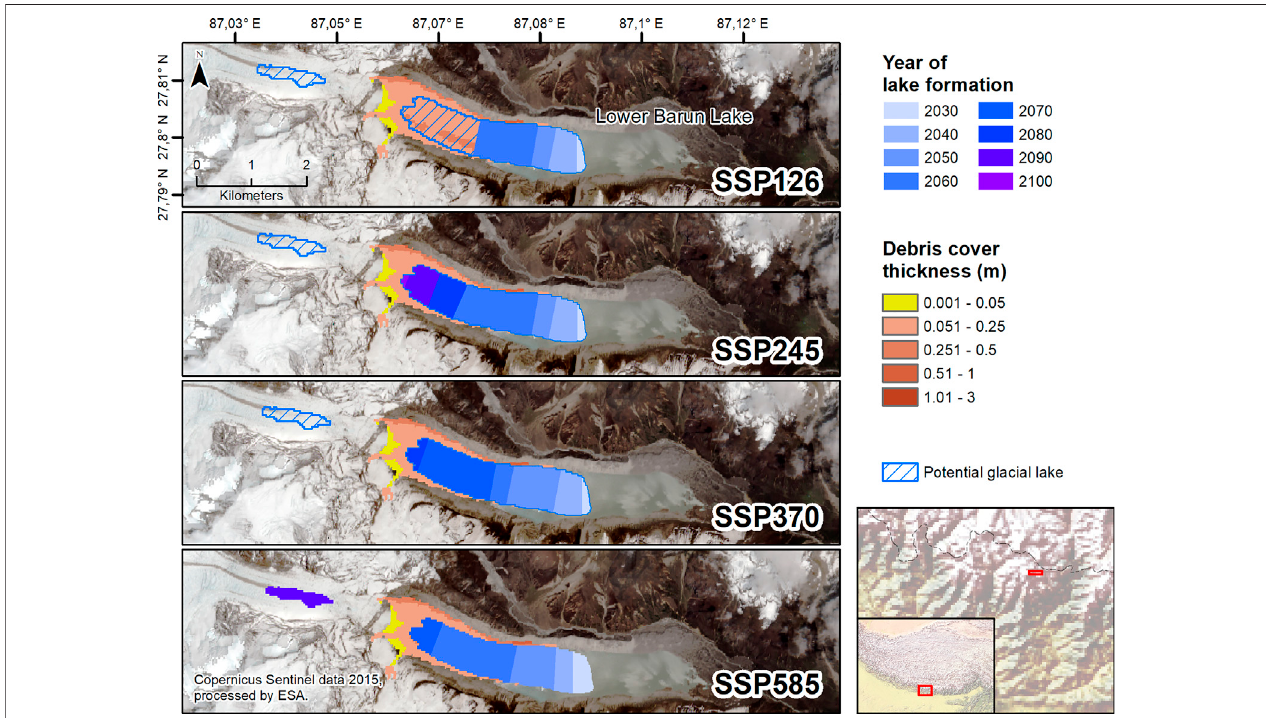
FIGURE 11 | Potential extension of Lower Barun glacial lake under different SSP scenarios until 2100. Lake extent based on CESM2-WACCM modeling, debris cover data by Rounce et al. (2021).